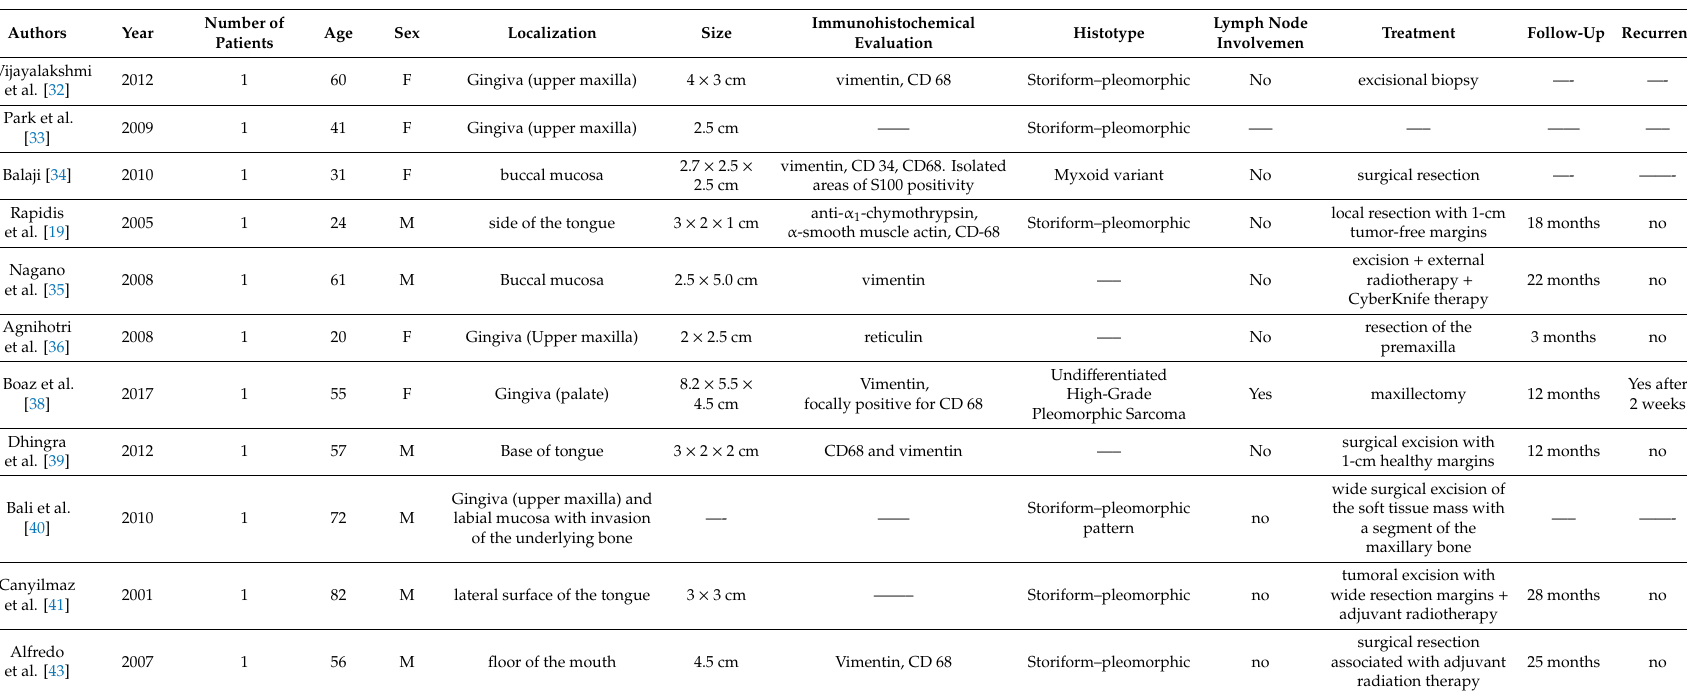
Table 1. Data for: name of the study, year of publication, number of the patients, age of the patient, sex of the patient, localization and dimension of the lesion, immunohistochemical positivity, histotype, lymph node involvement, treatment, follow-up period, and eventual